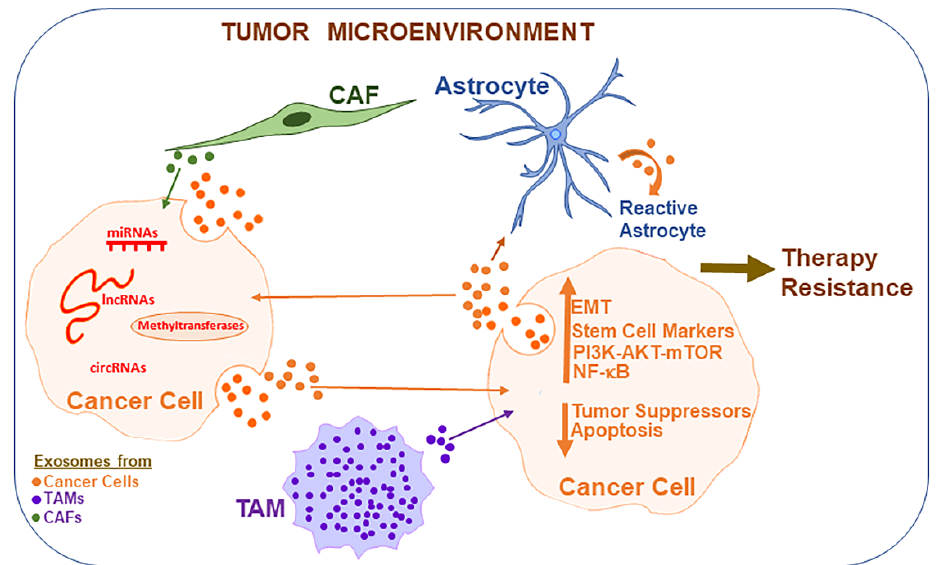
Figure 1. Exosome-mediated epigenetic regulation of cancer therapy resistance. Within the tumor microenvironment, various cell types communicate with each other leading to conditions favoring aggressive tumors and resistance against therapies, with exosomes playing an important role in cellular communications. Exosomes are released by various cell types and they transport epigenetic factors such as miRNAs, lncRNAs and circRNAs, in addition to carrying methyltransferases, all of